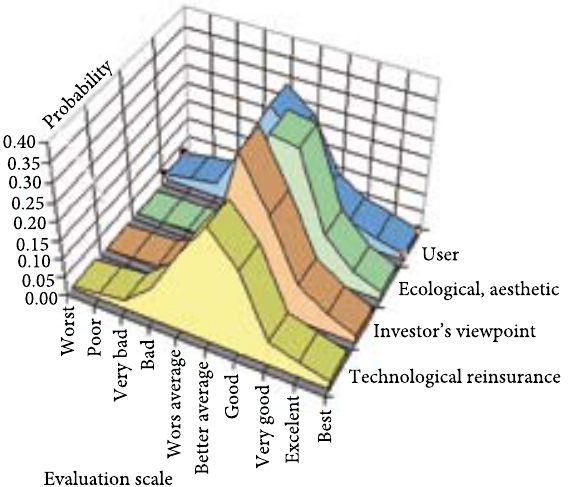
Fig. 4. Graph of a variant evaluation: cable